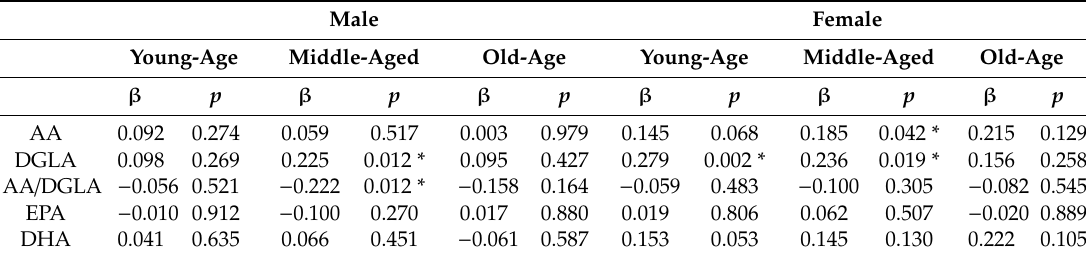
Table 5. Multiple linear regression analysis with SROS as dependent